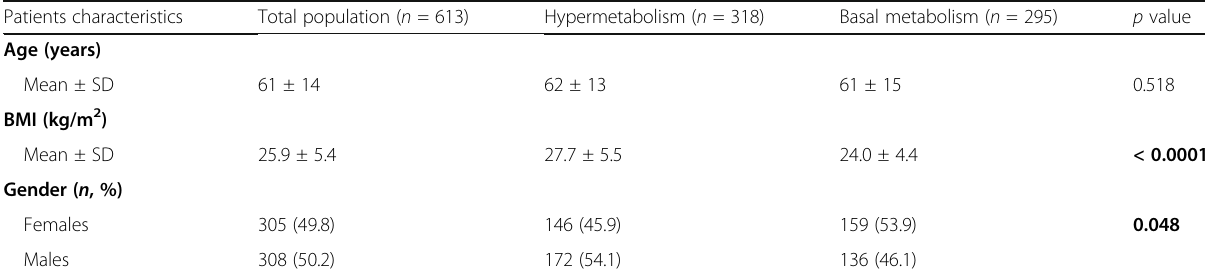
Table 1 Patients characteristics Patients